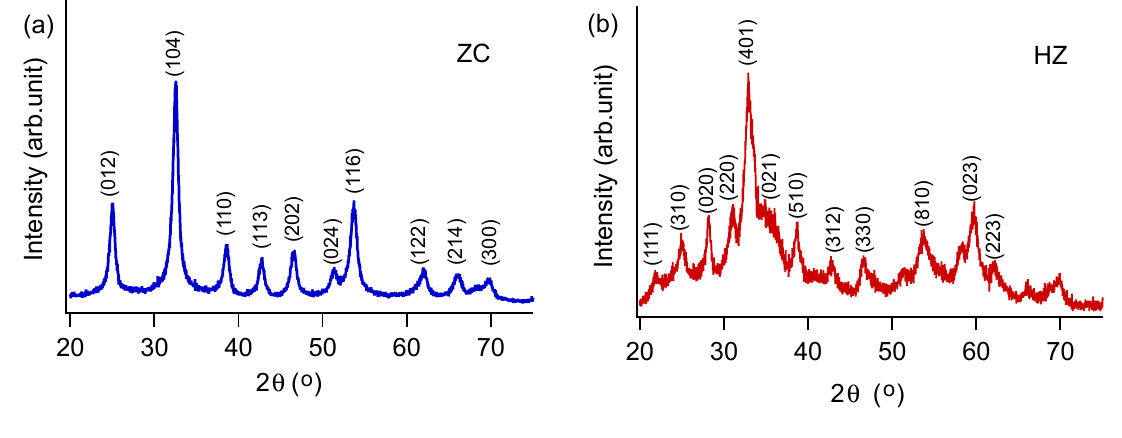
(OH) (CO ) (JCPDS 19-1458). 5 6 3 2